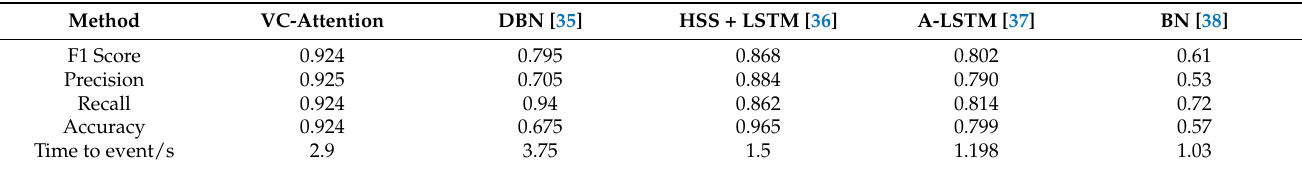
Table 3. Comparison of prediction and evaluation indicators by different methods.